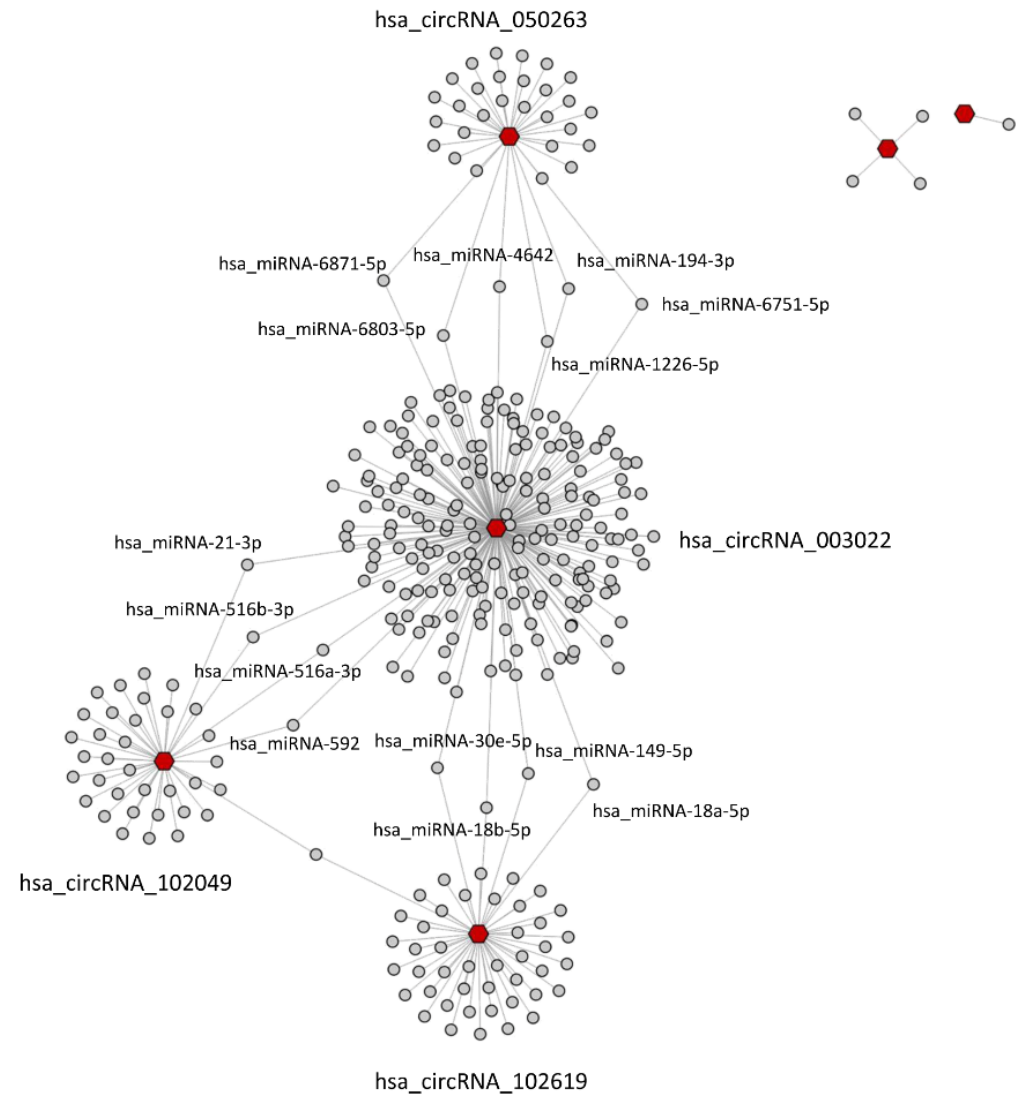
Figure 5. circRNA-miRNA network was reconstructed by Cytoscape 3.9.0. Red dots represent hasa_circRNAs, whilst hsa_miRNAs are shown as grey dots. Hsa_miRNAs functioning as bridges between hsa_circ_RNAs clusters are labeled.